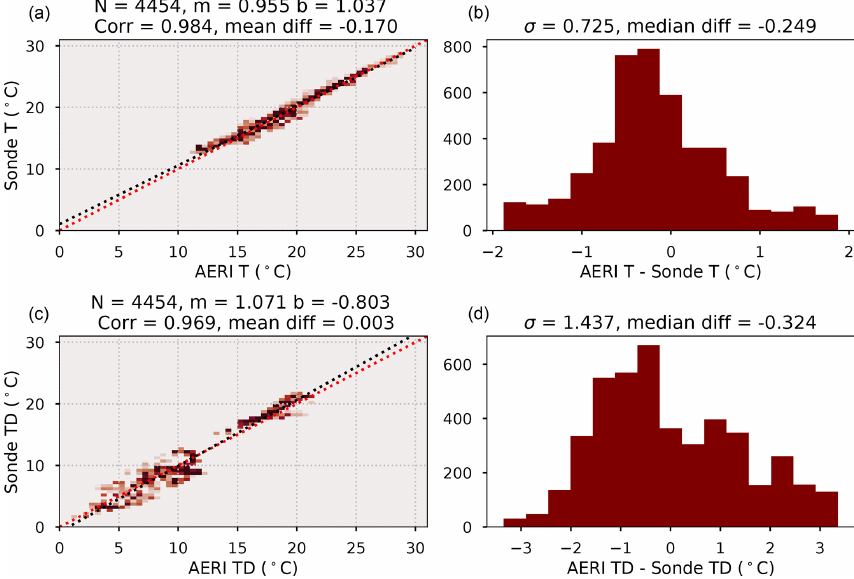
Figure 10. Similar to Fig. 5 but comparing thermodynamic measurements from the radiosondes and the DL.